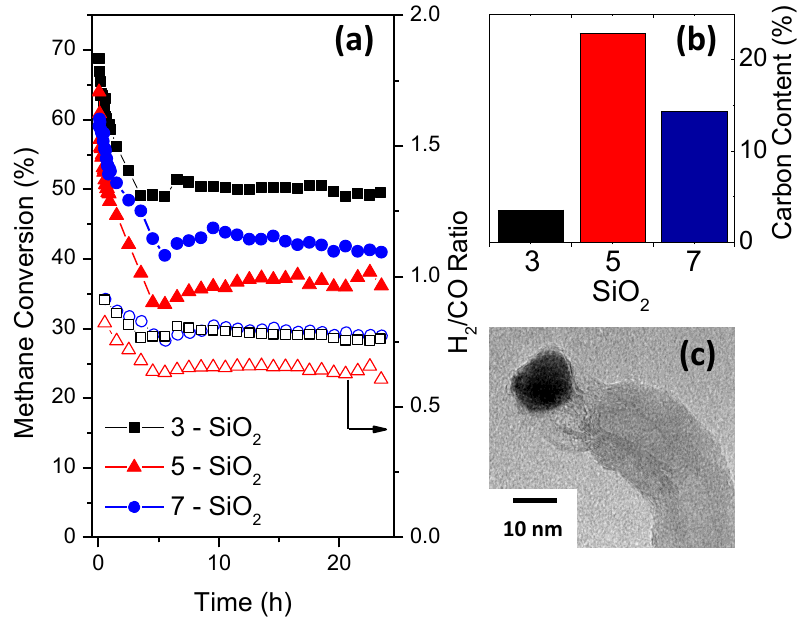
Figure 7. Twenty four hour stability tests with methane conversion ( a ) and accompanying H 2 /CO production ratio during dry reforming of methane over 5% Ni supported by 3, 5 and 7-SiO 2 with ( b ) showing carbon formation determined by TGA and ( c ) TEM of spent 3-SiO 2 . Conditions: WHSV = 144 L/(h·g cat ), catalyst loading = 0.025 g, N 2 /CH 4 /CO 2 = 1:1:1 at a temperature of 700